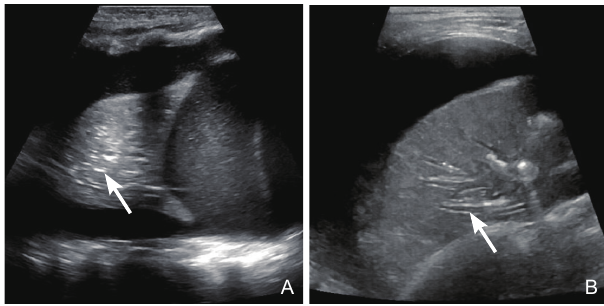
Figure 8 Atelectasis sonograms. (A) Air bronchogram (arrow); (B) Fluid bronchogram